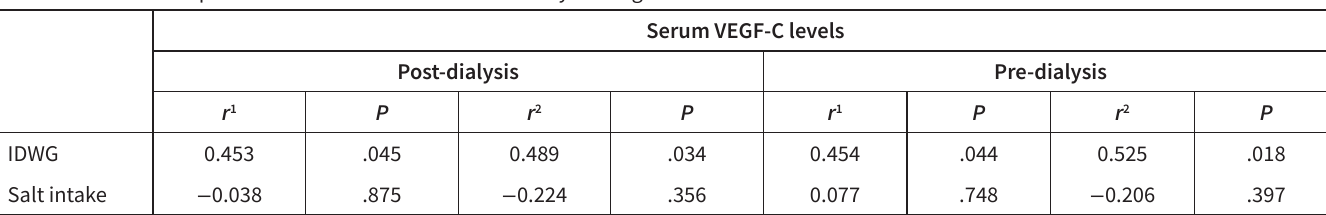
Table 3. Relationship Between VEGF-C Levels and Interdialytic Weight Gain and Salt Intake